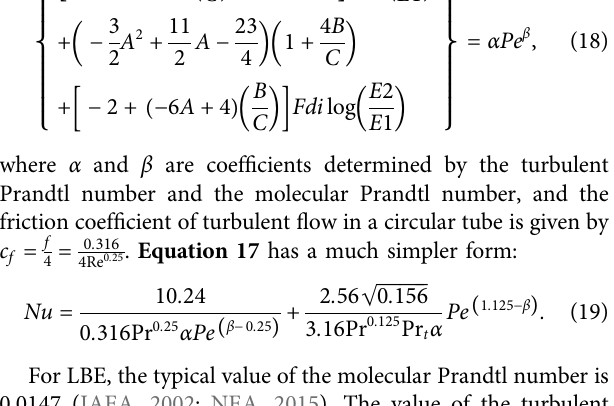
FIGURE 5 | Deviation of Eq. 20 from experimental LLM data in the